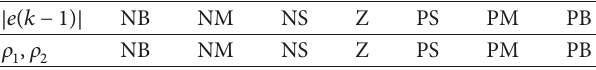
Table 6: The fuzzy rules of FMFAC and